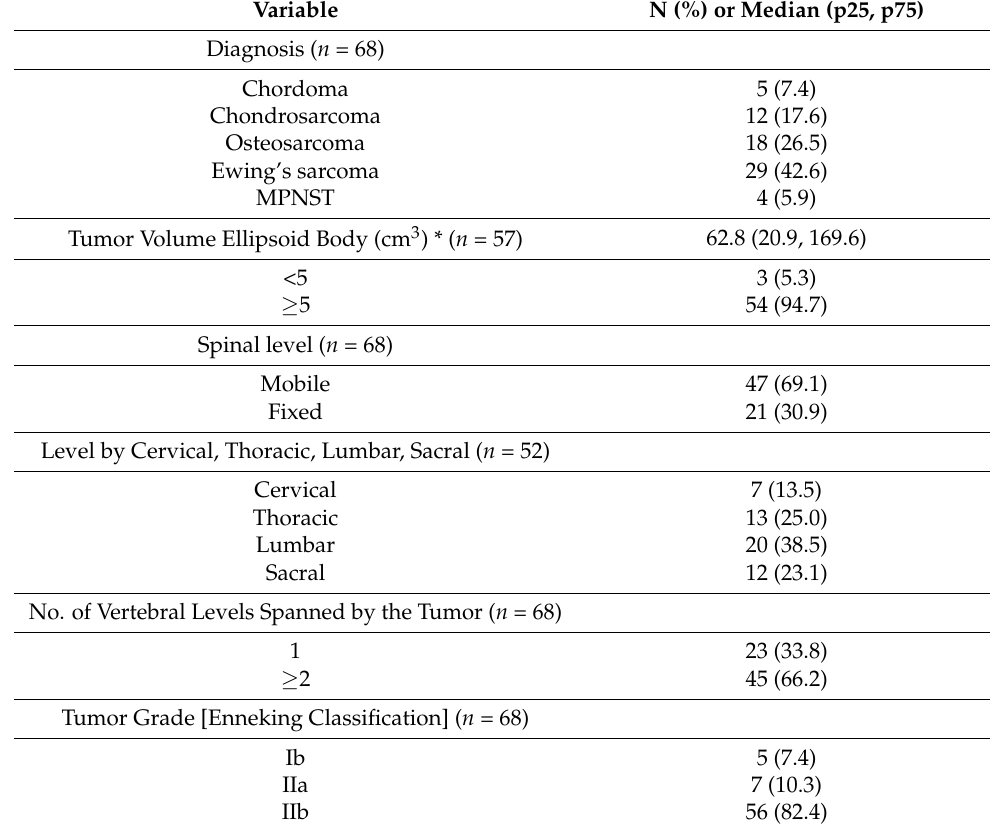
Table 2. Summary of malignant spinal tumor